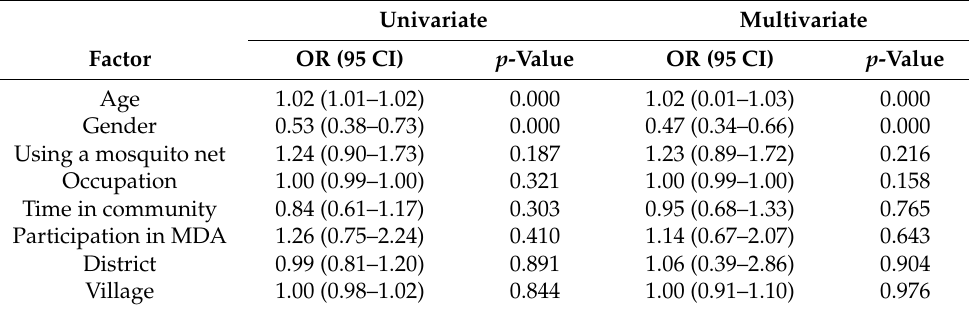
Table 5. Logistic regression estimates of the risk factors of LF infection.